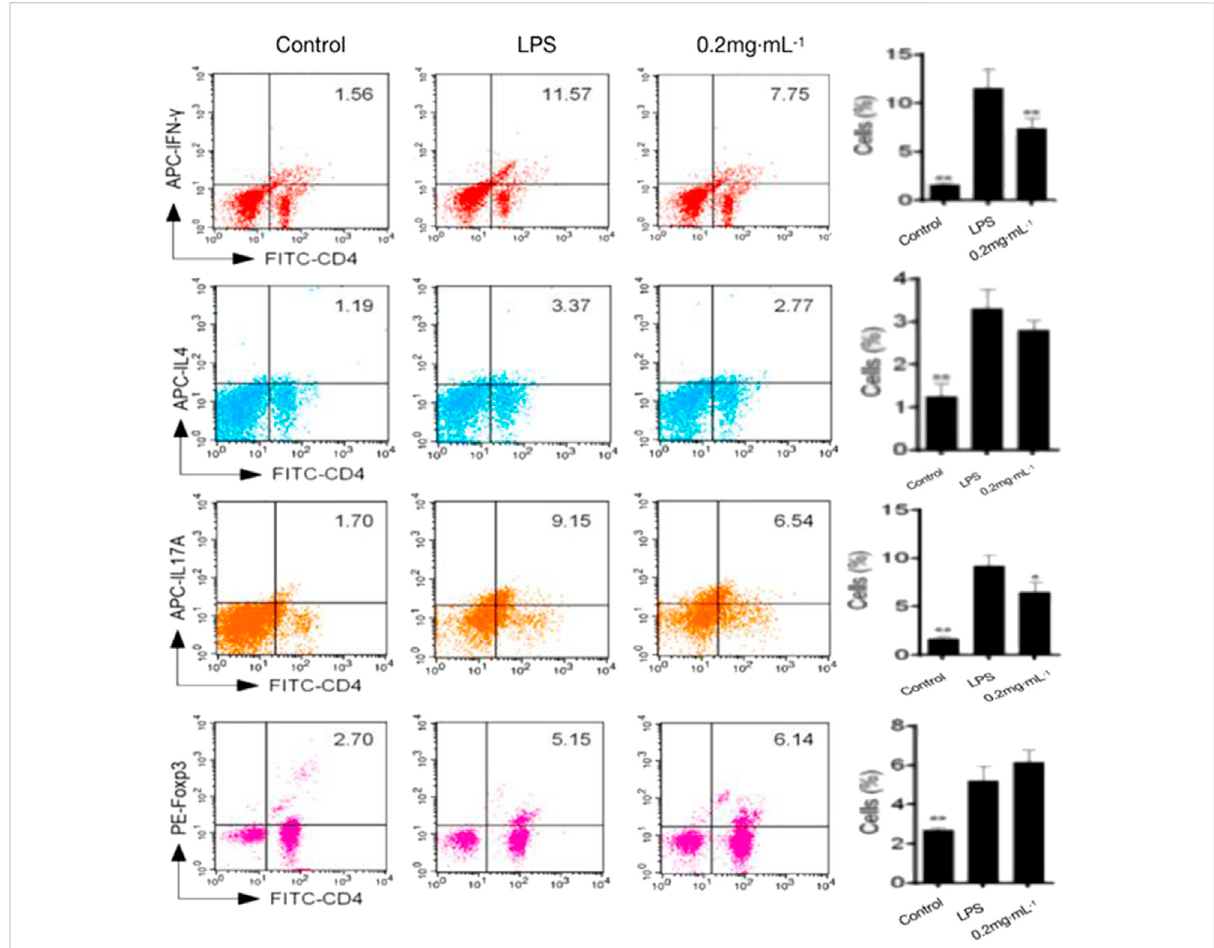
FIGURE 4 Effects of DF on the proportion of Th